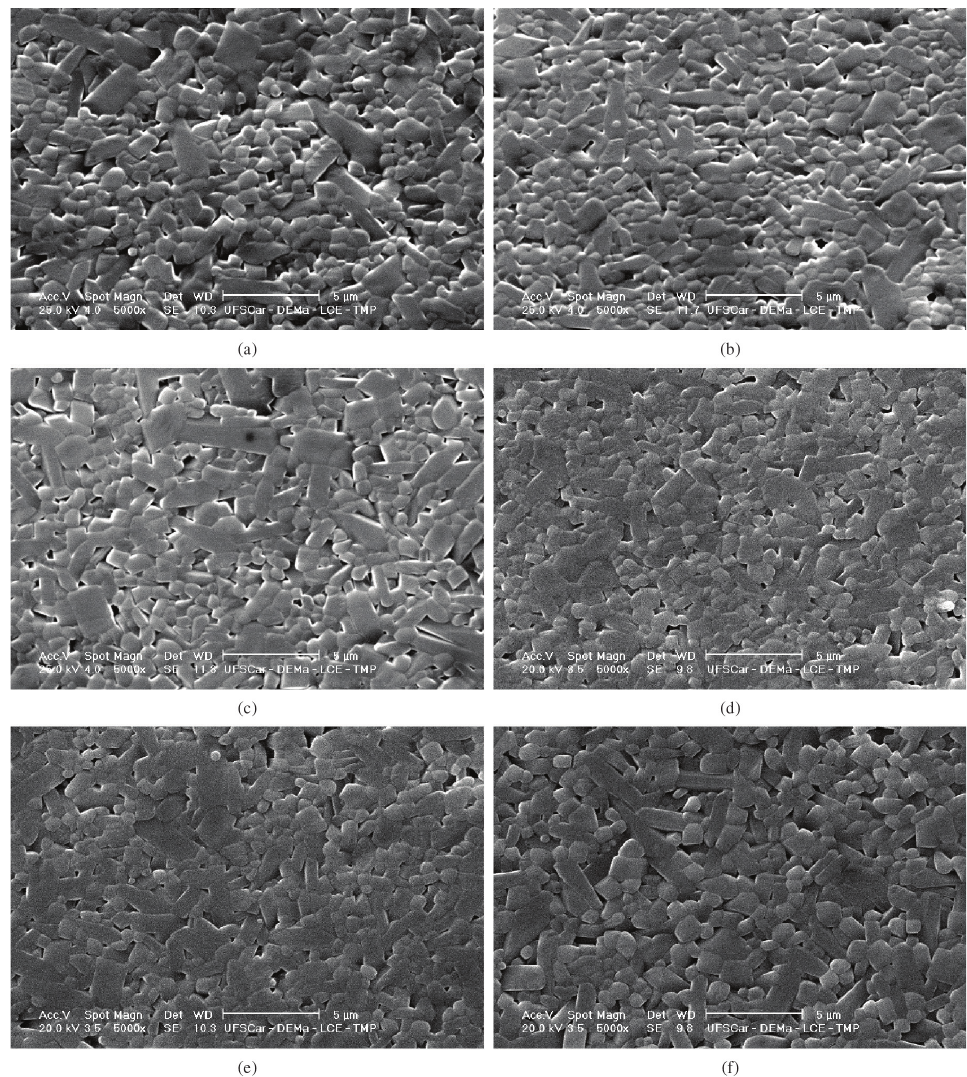
Figure 13. SEM micrographs of La (d) 0.5L, (e) 1L, (f)